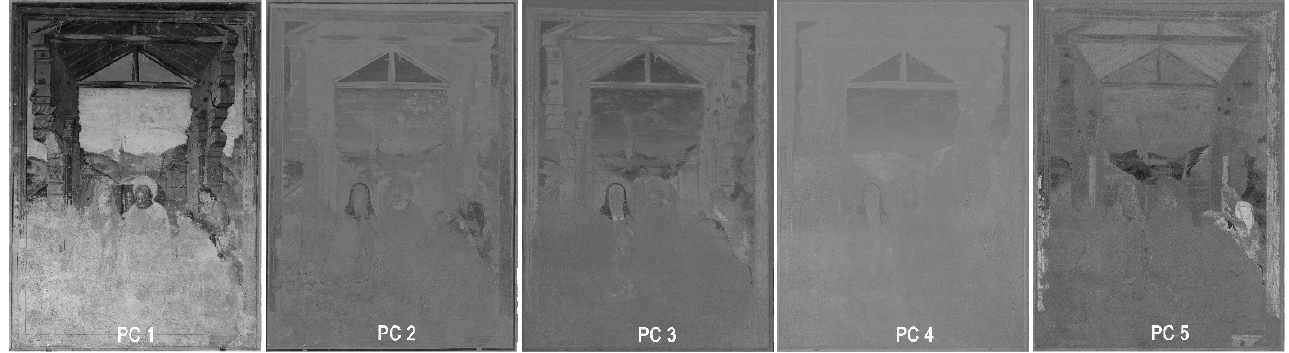
Figure 7. Overview of the PCA orthoimages.